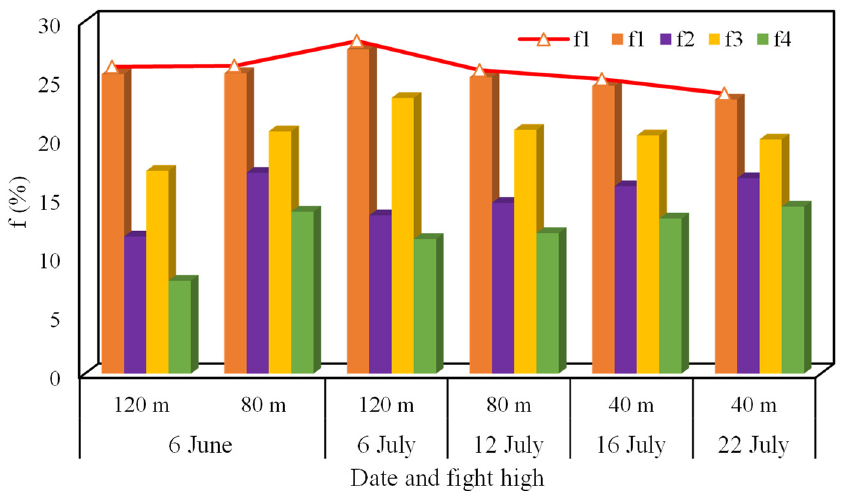
Figure 8. The temporal pattern histogram of vegetation coverage. The f1 and f2 represent the vegetation coverage of not considering and considering the shaded soil based on supervised classification, respectively; f3 and f4 represent the vegetation coverage of not considering and considering the shaded soil based on the supervised classification and normalized difference vegetation index (NDVI), respectively.